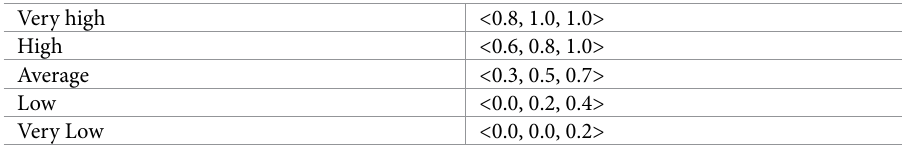
Table 2. Fuzzy numbers for linguistic